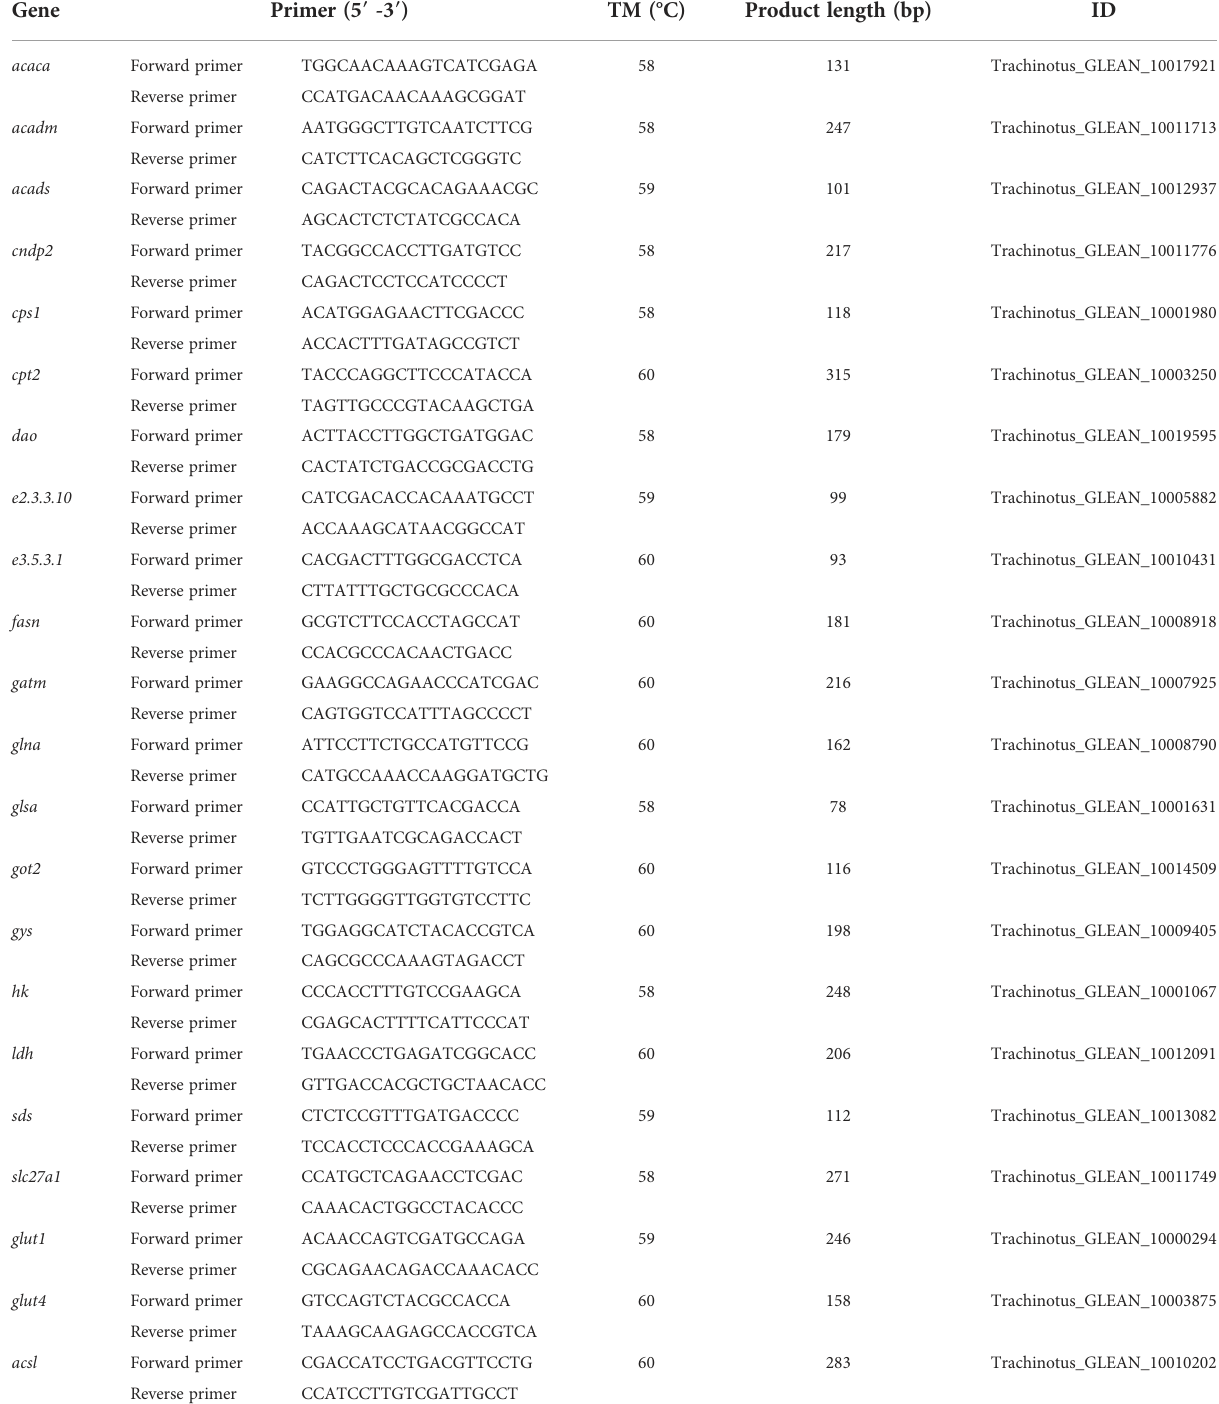
TABLE 1 Primer information for